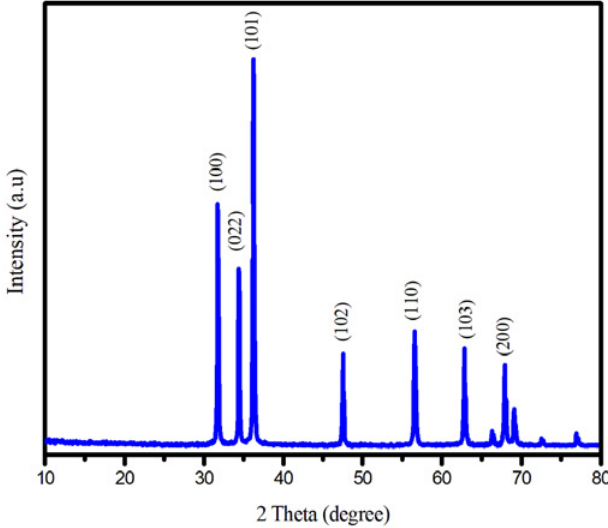
Fig. 1. XRD pattern of biosynthesized ZnO nanoparticles Table 1. Structural parameters of the biosynthesized ZnO Average Average crystal size Average dislocation density micro (nm) (δ) x 10 15 strain (ε)